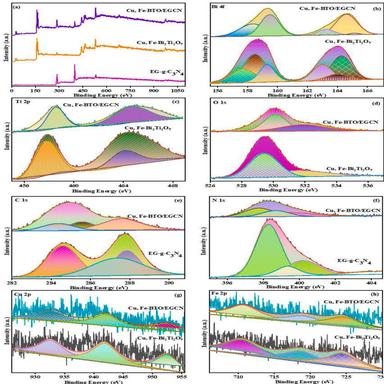
XPS-survey spectra of (a) EG-g-C3N4, Cu, Fe co-doped Bi2Ti2O7, and Cu, Fe-BTO/EGCN, High-resolution fitted XPS spectra of (b) Bi 4f (c) Ti 2p, and (d) O 1 s, (e) C 1 s, (f) N 1 s, (g) Cu 2p and (h) Fe 2p.